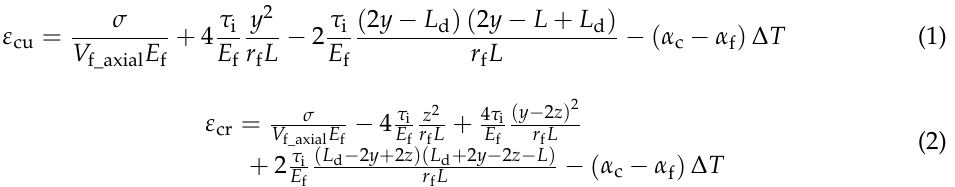
Figure 2. The schematic figure for fiber slipping relative to matrix upon: ( a ) unloading; and ( b ) reloading [18].